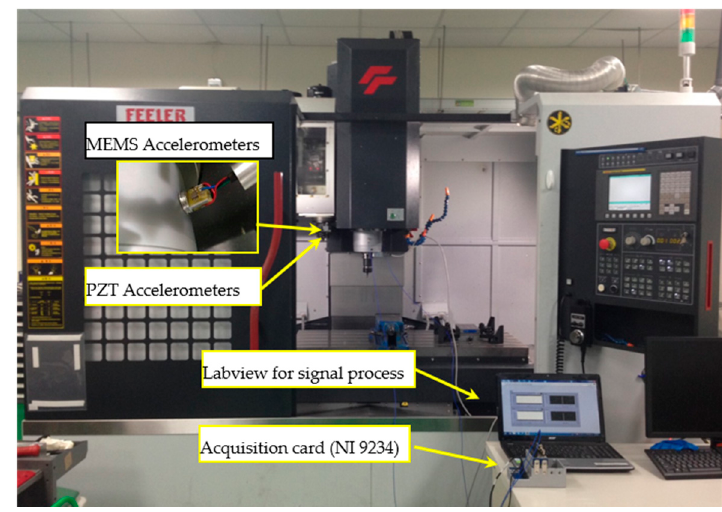
Figure 8. The arrangement of cutting experiment, including the dual ‐ axis MEMS accelerometer, two PZT (PCB 353B15) accelerometers, the data acquisition card (NI 9234) and the Labview programs for signal process.